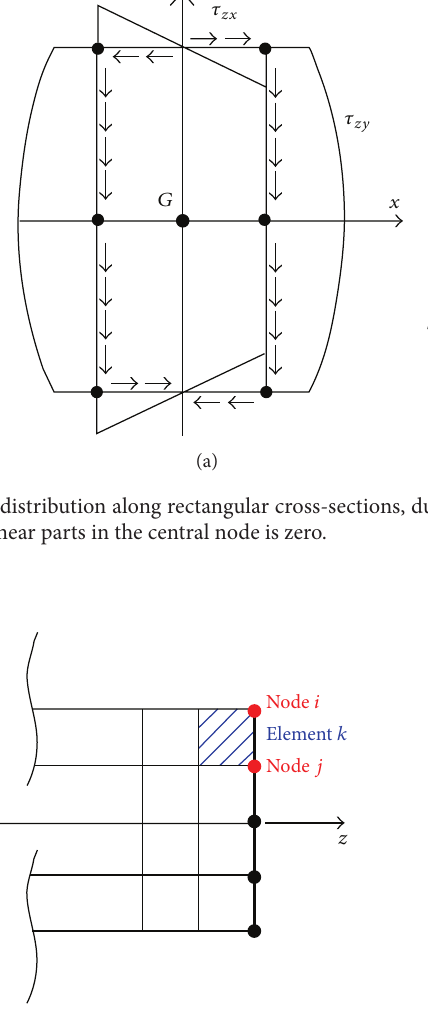
Figure 5: Profile of detailed 3D beam model: a generic shell element 𝑘 and the two nodes at interface, 𝑖 and 𝑗 [11].